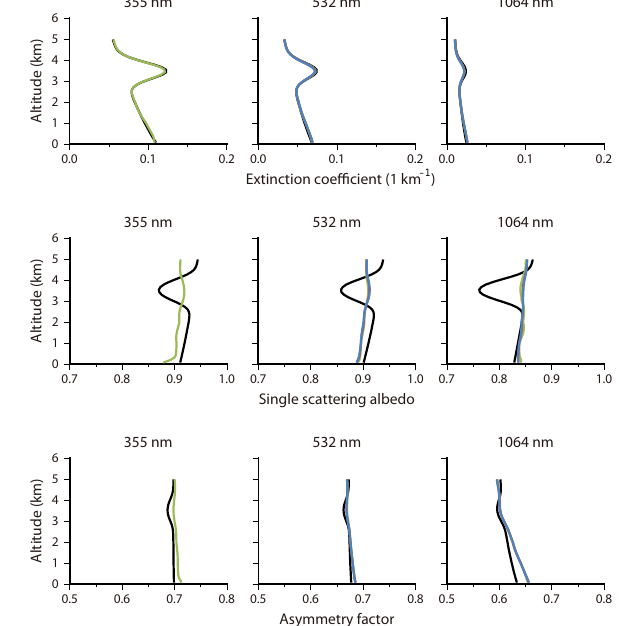
Figure 13. Retrieval results from the simulated data for the trans- ported pollution aerosol: the extinction coefficients, the single- scattering albedo, and the asymmetry factor. “True” values are shown by the black lines, the colored lines indicate retrievals from Type 1 data set (MIEL data at 532 and 1064nm) (blue), Type 2 data set (MIEL data at 532 and 1064nm; HSRL data at 532nm) (red), and Type 3 data set (MIEL data at 532 and 1064nm; HSRL data at 355 and 532nm) (green). The red and blue lines completely